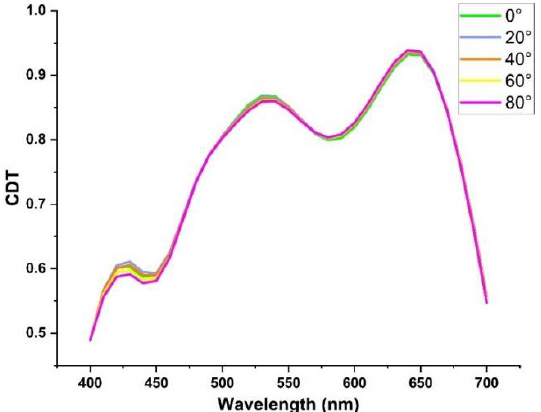
Figure 8. CDT under incident light with different angles from 0° to 80°.